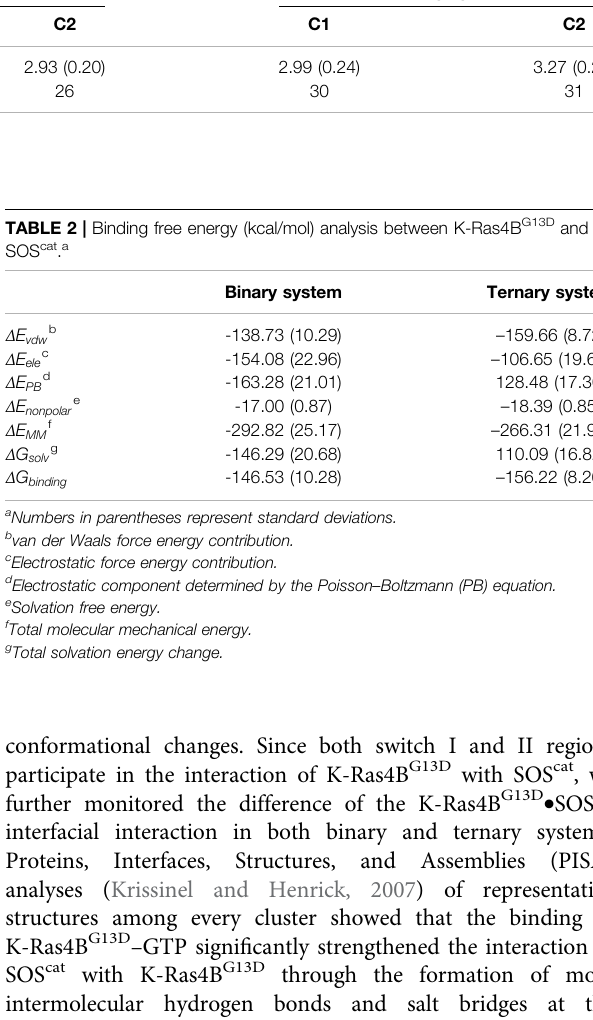
TABLE 1 | Summary of RMSDs of C α atoms, salt bridge, and hydrogen bond numbers along the K-Ras4B G13D